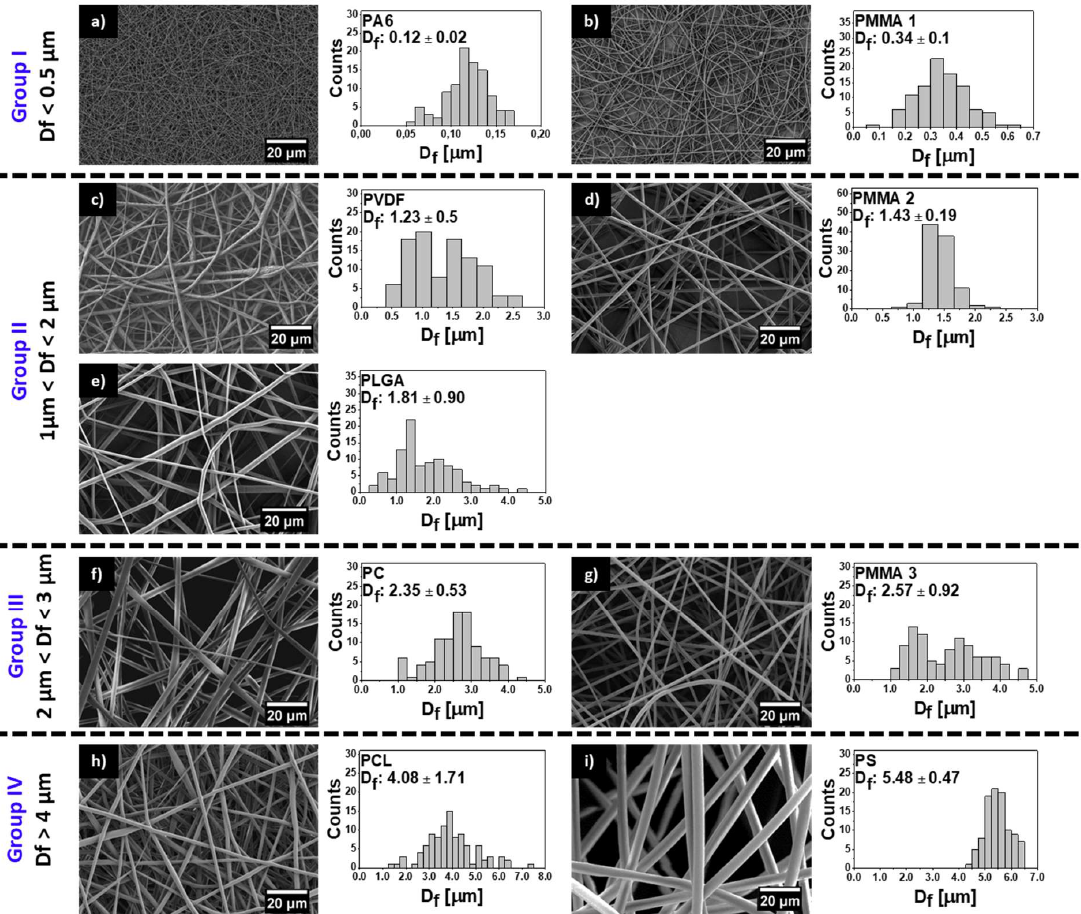
Figure 1 . Scanning electron microscopy (SEM) images of electrospun fibers with fiber diameter ( D f ) histograms for ( a ) hydrophilic nylon 6 (PA6), ( b ) poly(methyl methacrylate) (PMMA) 1, ( c ) polyvinylidene fluoride (PVDF), ( d ) PMMA 2, ( e ) poly(lactic- co -glycolic acid) (PLGA), ( f ) polycarbonate (PC), ( g ) PMMA 3, ( h ) polycaprolactone (PCL), and ( i ) polystyrene (PS).